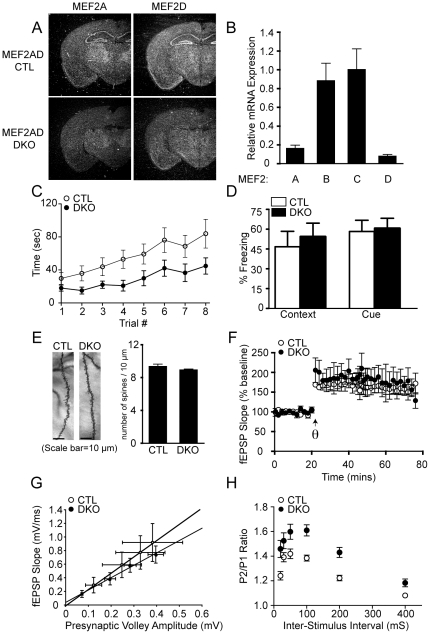
Brain-specific deletion of Mef2a and Mef2d causes impairments in motor coordination, as well as presynaptic release probability.(A) Detection of Mef2a and Mef2d transcripts by in situ hybridization in littermate CTL and Mef2a/d
DKO (DKO) mice. Arrow indicates hippocampus. (B) Expression level of MEF2 transcription factors in the hippocampus of Mef2a/d
DKO mice as detected by quantitative RT-PCR. RNA was isolated from the hippocampus of 4 week old animals (n=3/genotype), and then expression determined by quantitative PCR. The fold change in RNA was calculated using the comparative Ct method, normalizing to GAPDH as a control. (C) Mef2a/d
DKO mice exhibit impaired motor coordination as assessed by falling off the accelerating rotarod faster than littermate CTLs (F1,7=27.64, P<0.05; CTL, n=8; Mef2a/d
DKO, n=10), posthoc analysis demonstrated that trial numbers 3–8 were significantly different between the Mef2a/d
DKO and CTL mice. (D) Mef2a/d
DKO mice show normal associative learning, as assessed by context- and cue-dependent fear conditioning (CTL, n=8; Mef2a/d
DKO, n=10). (E) Representative images of Golgi-stained CA1 pyramidal neurons and a bar graph comparing the number of dendritic spines per 10 µm length of dendrite from littermate CTL and Mef2a/d
DKO mice (n=31 dendritic segments from 31 neurons of two CTL mice and n=68 dendritic segments from 68 neurons of four Mef2a/d
DKO mice). (F) CA1 LTP induction and maintenance is normal in DKO mice (CTL, n=3; Mef2a/d
DKO, n=3). (G) Input-output relations are normal in Mef2a/d
DKO mice (CTL, n=4; Mef2a/d
DKO, n=4; solid lines indicate lines of best fit.). (H) Paired-pulse facilitation is increased in Mef2a/d
DKO mice at Inter-Stimulus Interval 20, 30, 50, 100, 200 and 400 (mS) compared to littermate CTLs, suggesting decreased presynaptic release probability (CTL, n=8; Mef2a/d
DKO, n=7). All data is shown as mean ± SEM.